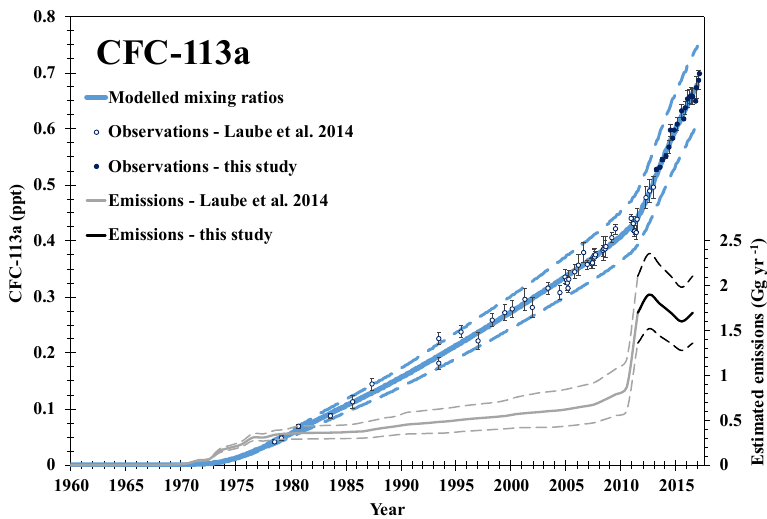
Figure 3. CFC-113a modelled and observed mixing ratios at Cape Grim 1960–2017 and estimated global annual emissions of CFC-113a. The observations are from July 1978–February 2017 with 1 σ standard deviations as error bars. Data prior to 4 December 2012 are from Laube et al. (2014). The blue solid line represents the modelled mixing ratios with uncertainties (dashed blue line). The dashed black and grey lines represent the modelled “best-fit” emissions with uncertainties (short-dashed). The method used for calculating the upper and lower emission bounds is in the